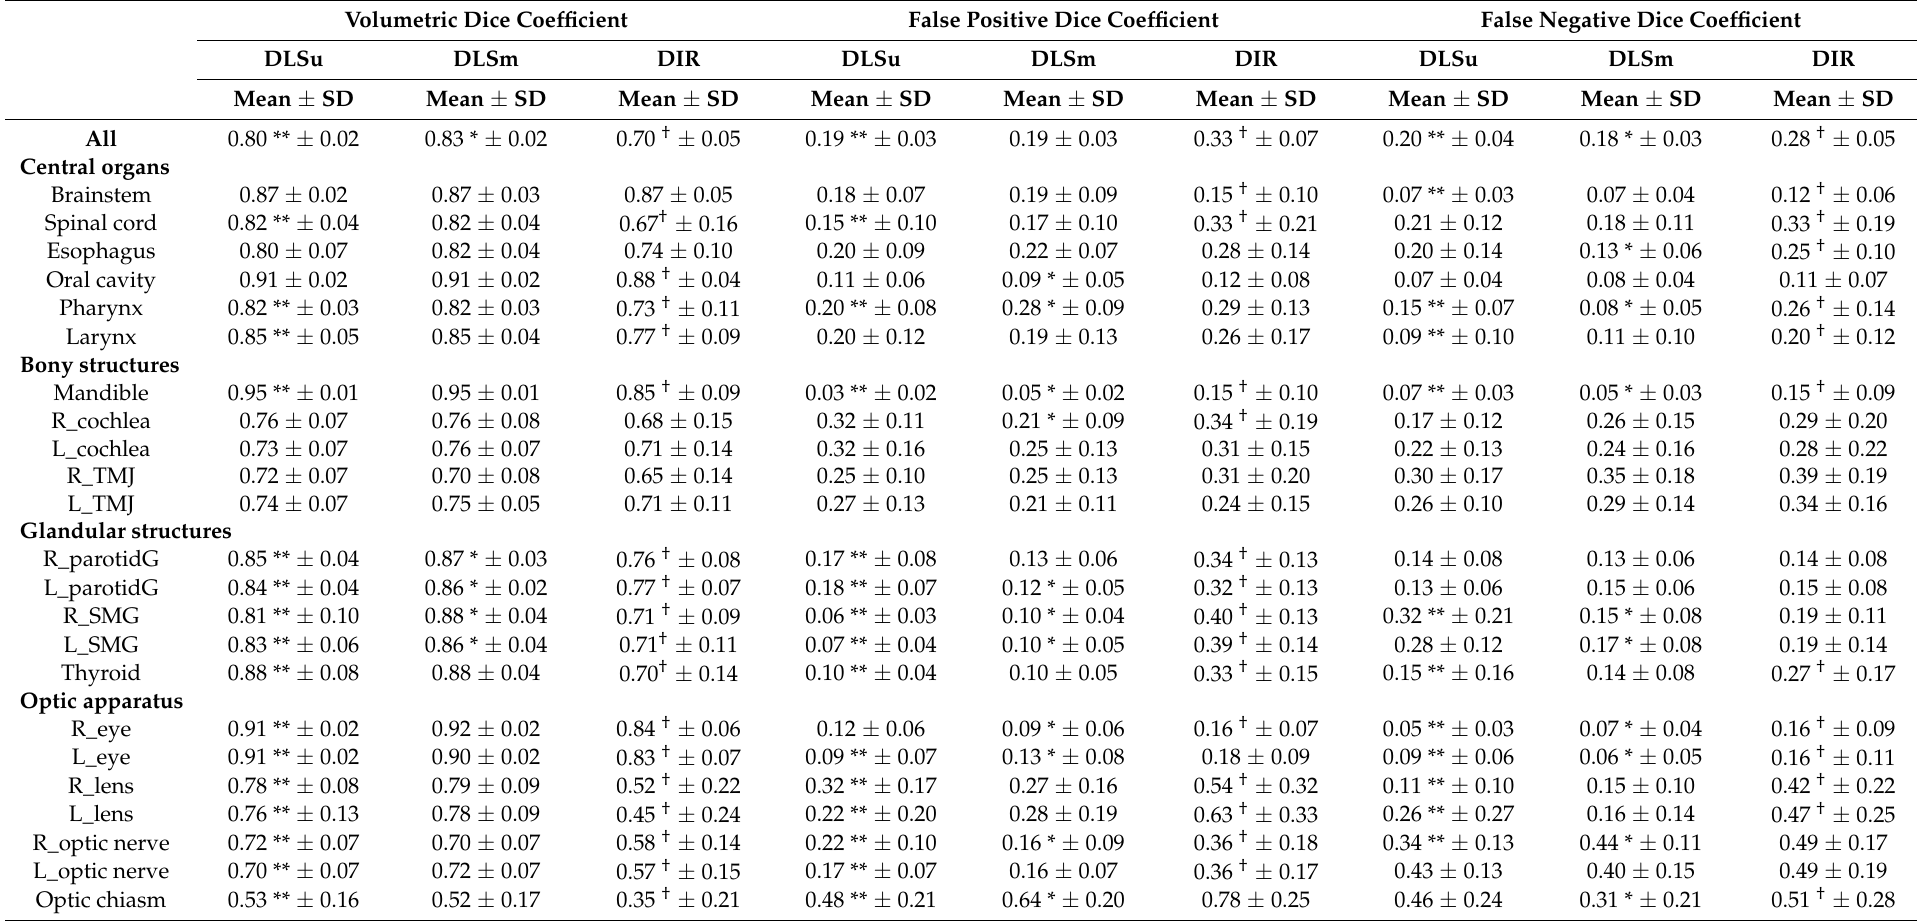
Table 1. Average volumetric Dice coefficient, false positive Dice coefficient, and false negative Dice coefficient for, deep learning-based segmentation from unmatched set (DLSu), matched training set (DLSm), and contouring from deformable image registration of primary planning computed tomography